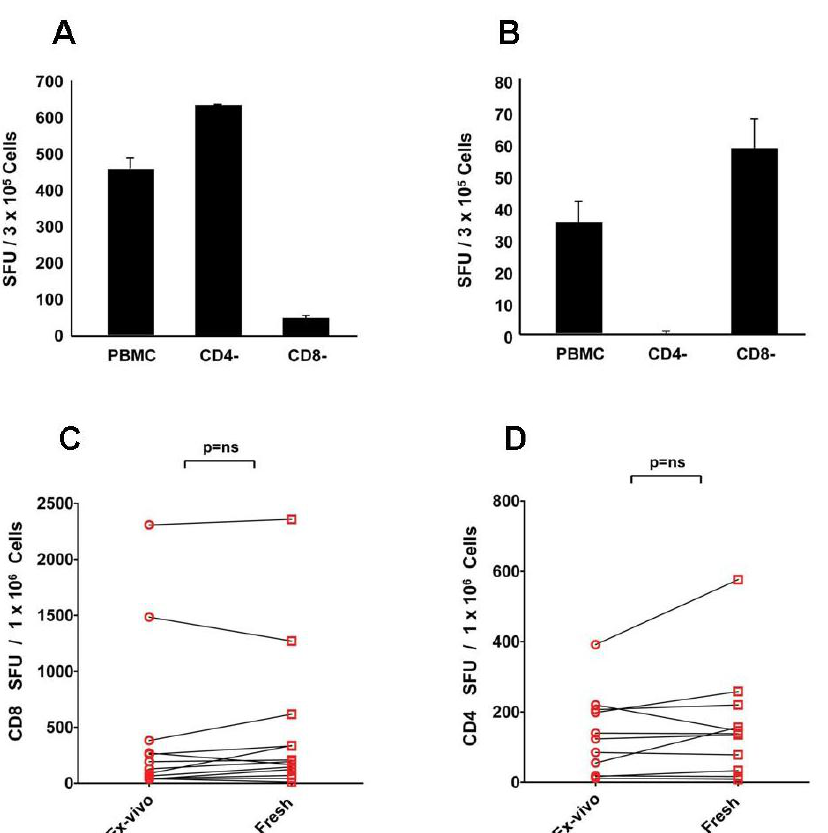
Figure 1. CD8 cells respond to CEF peptides ( A ), and CD4 cells to mumps antigen ( B